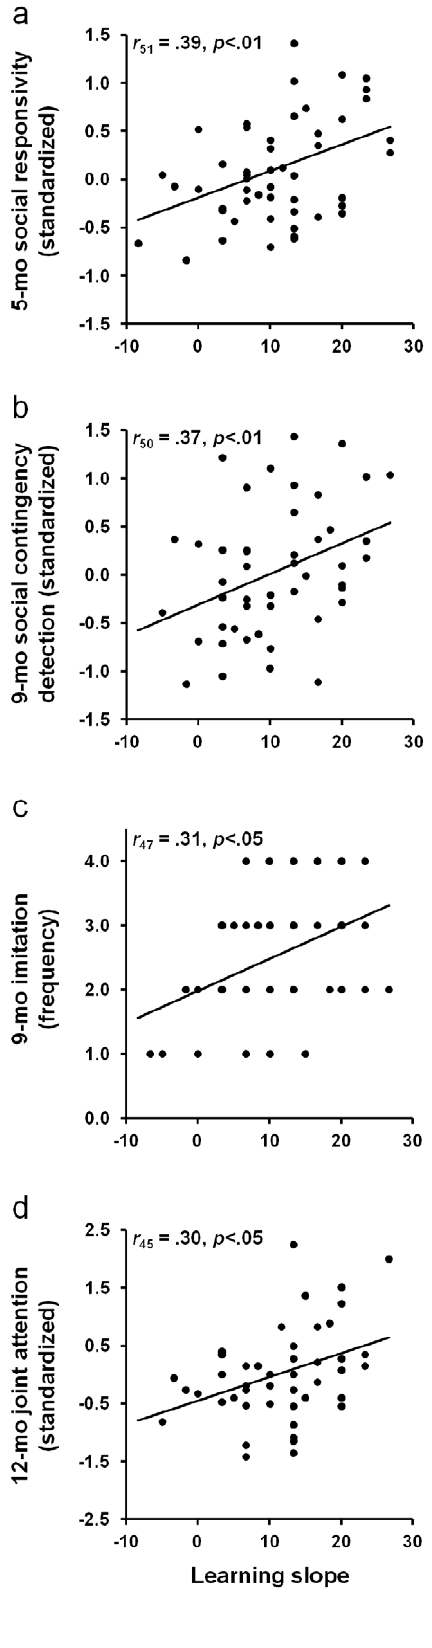
Figure 2. Predictive relation between early learning and social behavior during the first year of life. Individual differences in associative learning measured at 1 month of age were correlated significantly with measures (a) 5-month Social Responsivity, (b) 9-month Social Contingency Detection, (c) 9-month Imitation, and (d) 12-month Joint